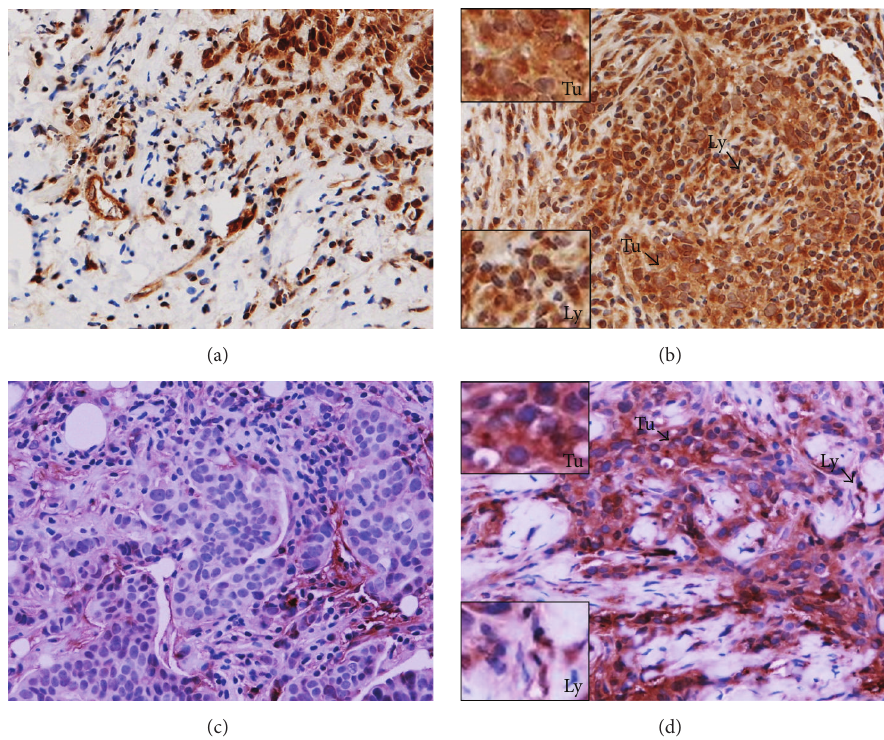
Figure 6: IL-4 (a, b) and IL-10 (c, d) expression in the sections of LLABCs, using IHC staining, at 400x magnification. Briefly, heat-mediated antigen retrieval was performed using citrate buffer, pH 6 (20 mins). The sections were then incubated with polyclonal Abs to IL-4 (Abcam, ab9622) at a concentration of 4 𝜇 g/mL for 30 mins at RT and polyclonal Abs to IL-10 (Abcam, ab34843) at a 1: 400 dilution for 30 mins at RT. Polymeric HRP-linker antibody conjugate was used as secondary antibody. DAB chromogen was used to visualize the staining. The sections were counterstained with haematoxylin. (a, c) Low level of expression; (b, d) high level of expression. The 𝐻 score (% of positive cells (brown membrane/cytoplasmic-stained tumour and immune cells) × intensity of staining (1 to 3)) was used to assess the level of expression; low was ≤ 100 and high was > 100. Scoring performed on whole tissue section ( > 10 HPFs); Tu: tumour and Ly: